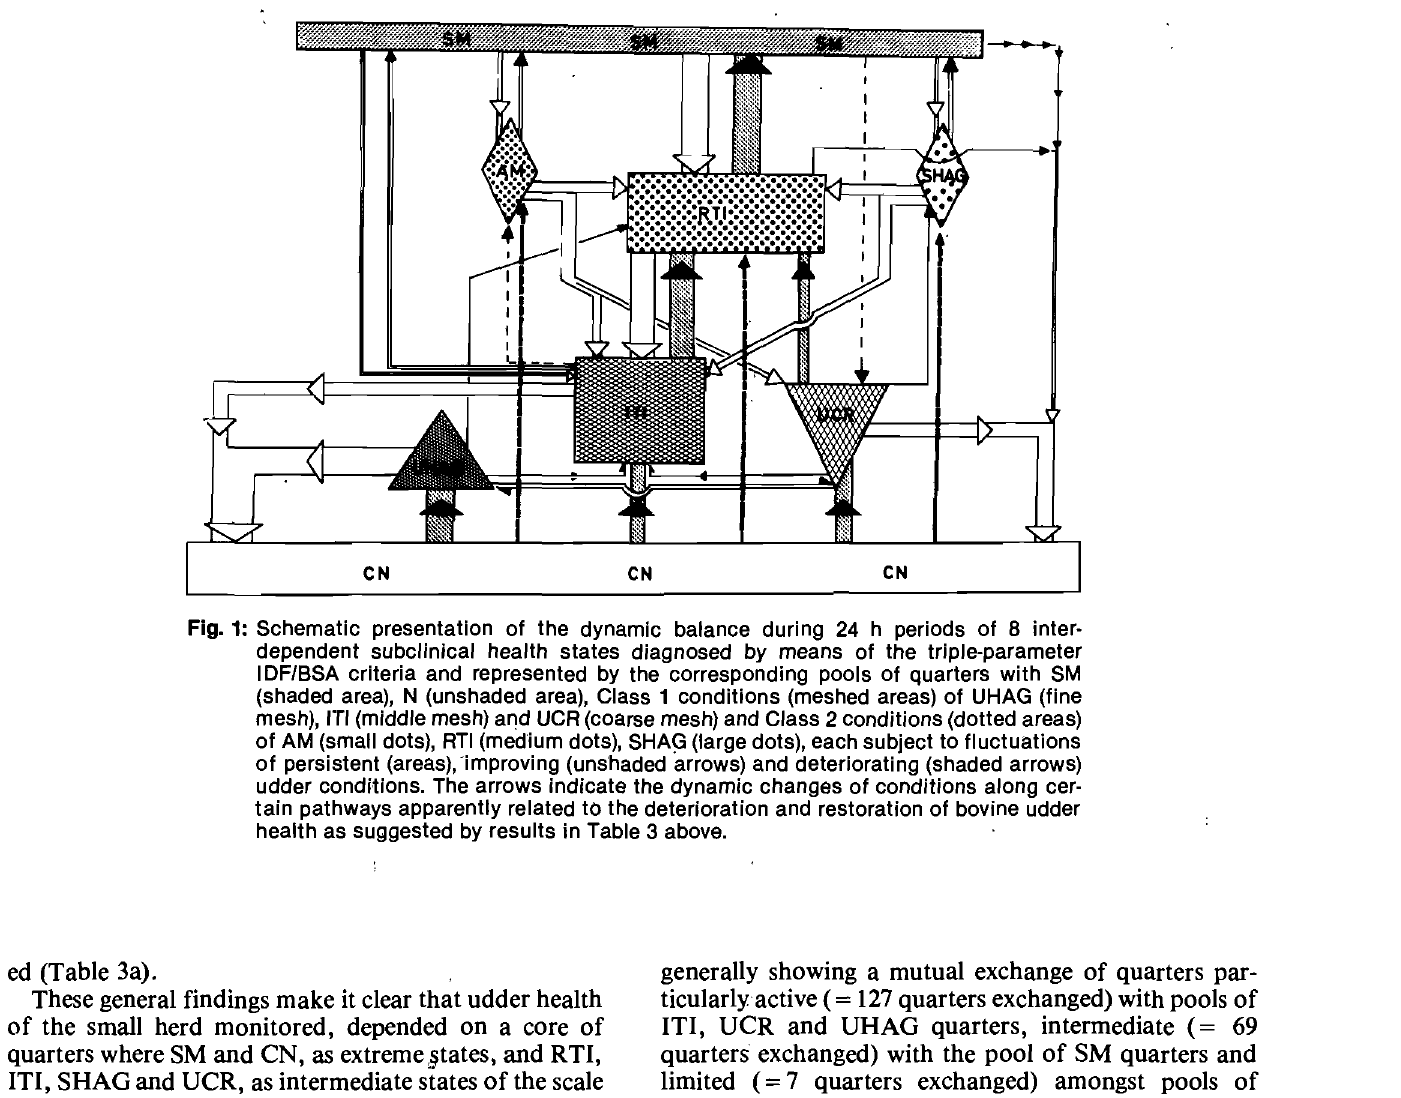
Fig. 1: Schematic presentation of the dynamic balance during 24 h periods of 8 inter· dependent subclinical health states diagnosed by means of the triple·parameter IOF/BSA criteria and represented by the corresponding pools of quarters with SM (shaded area), N (unshaded area), Class 1 conditions (meshed areas) of UHAG (fine mesh), ITI (middle mesh) and UCR (coarse mesh) and Class 2 conditions (dotted areas) of AM (small dots), RTI (medium dots), SHA(3 (large dots), each subject to fluctuations of persistent (areas), -improving (unshaded arrows) and deteriorating (shaded arrows) udder conditions. The arrows indicate the dynamic changes of conditions along cer tain pathways apparently related to the deterioration and restoration of bovine udder health as suggested by results in Table 3 above.